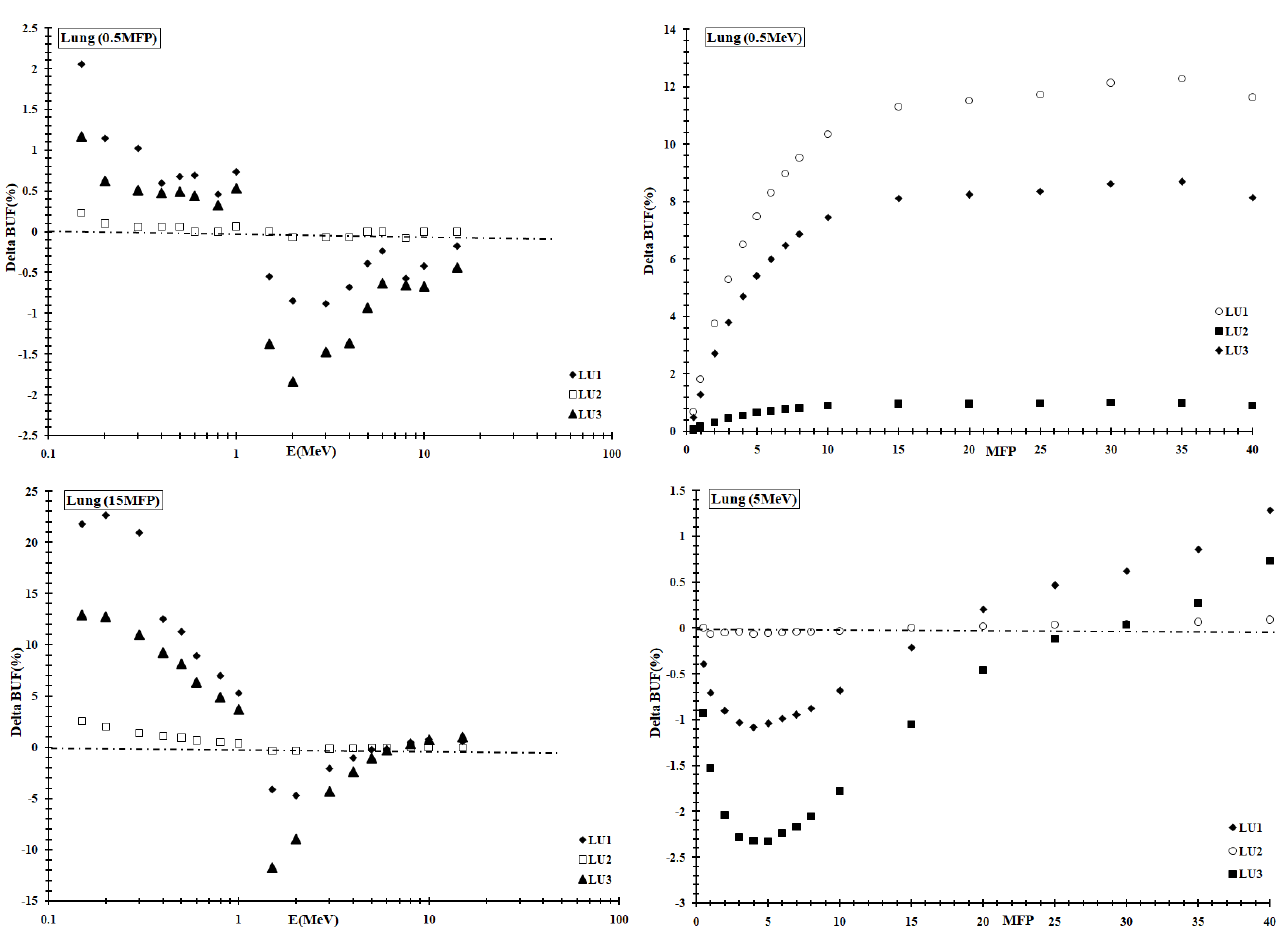
Figure 10. Buildup factor for lung tissue as a function of: ( left side ) photon energy for fixed depths between 0.5 and 40 mfp and ( right side ) depth for fixed photon energies between 0.15 and 15 MeV.